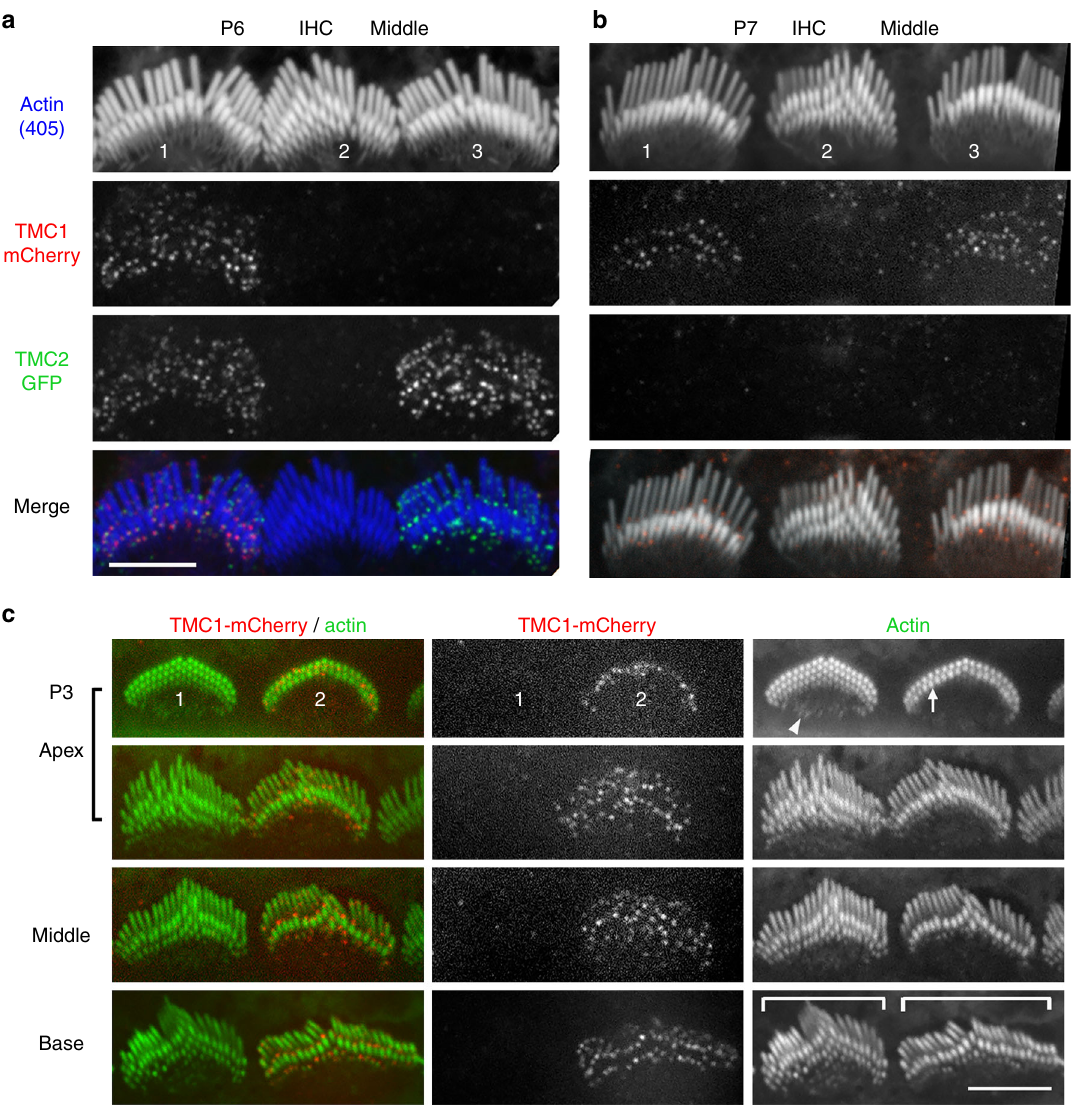
Fig. 8 TMC1 and TMC2 are required for normal stereocilia bundle development and morphology. a , b Confocal images of three IHC stereocilia bundles (1 – 3) from cochlear middle turn labeled with phalloidin (top panel), from transgenic mice aged P6 ( a ) and P7 ( b ), with a mosaic expression of TMC1- mCherry (second panel), and/or TMC2-GFP (third panel). Bottom panel — merge image of all three channels. Stereocilia bundles of IHCs that do not express TMC1-mCherry or TMC2-GFP (e.g., bundle 2 in a and b ) are clearly developmentally immature relative to IHC bundles expressing either TMC1- mCherry or TMC2-GFP. c Confocal images of two adjacent IHC bundles from the cochlear apex (top two panels), middle (third panel) and base (fourth panel), from transgenic mice aged P3, with a mosaic expression of TMC1-mCherry, and no TMC2-GFP. One IHC lacks both TMCs, and the second expresses only TMC1-mCherry. Note that in the absence of TMC1 and TMC2, stereociliary bundles have extra rows and morphology remains similar at the apex, middle and base. Conversely, expression of TMC1-mCherry is necessary and suf fi cient for the normal reduction in number of stereocilia rows, and the subtle widening of the angle of the bundle “ V ” -shape from apex to base. Scale bar = 5 µ